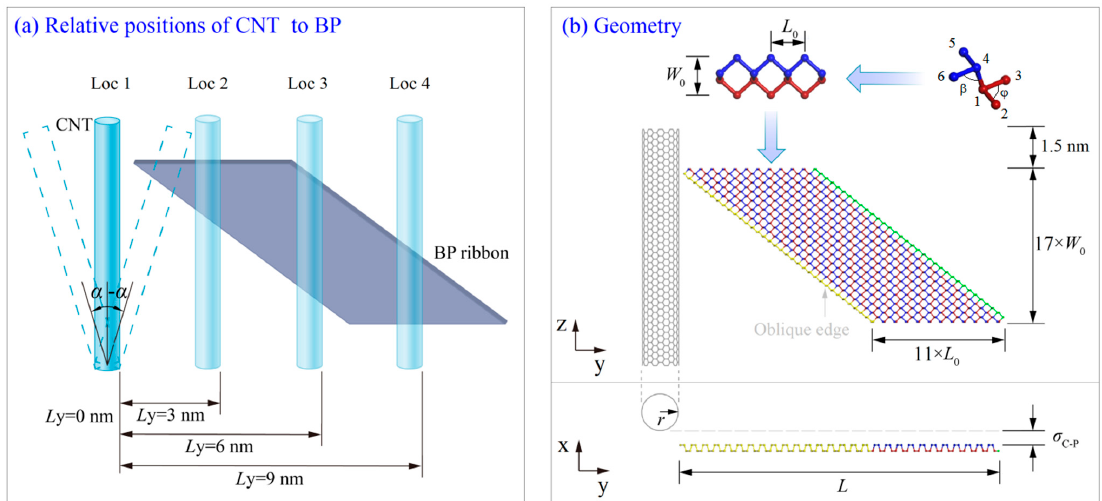
Factor 1: α = 0°, ±3°, ±6°, ±9°, ±12°, ±15°, ±18°, ±30°, ±45°, ±60°; Factor 2: L y = 0, 3, 6, and 9 nm.